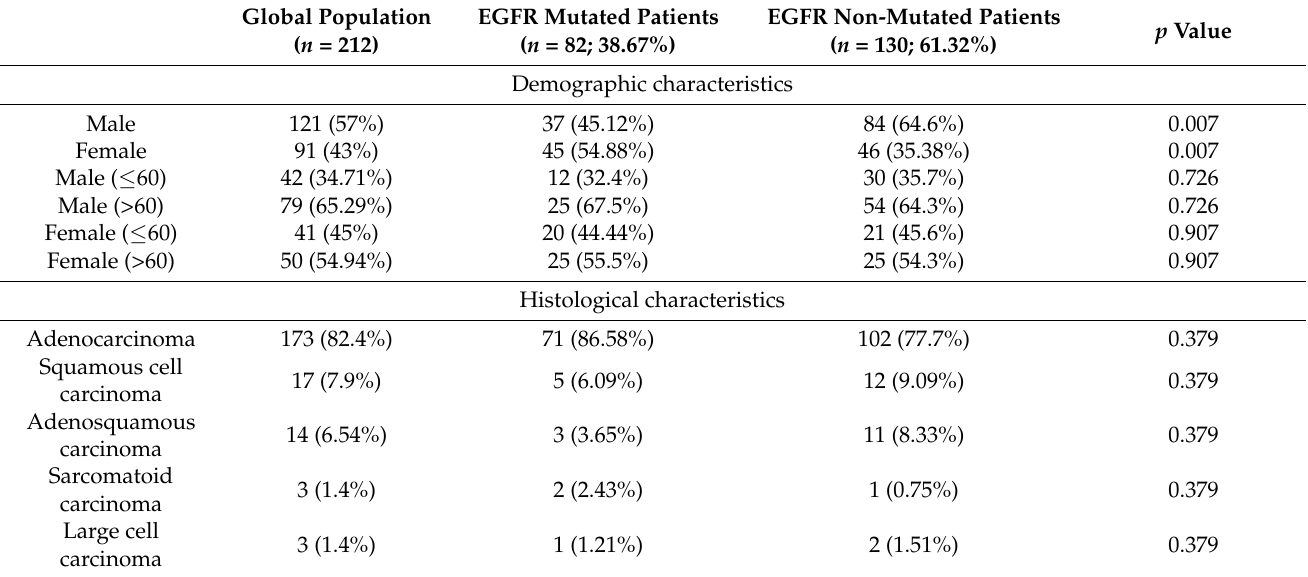
Table 1. Demographic and histological characteristics of total, EGFR mutated, and non-EGFR mutated patient